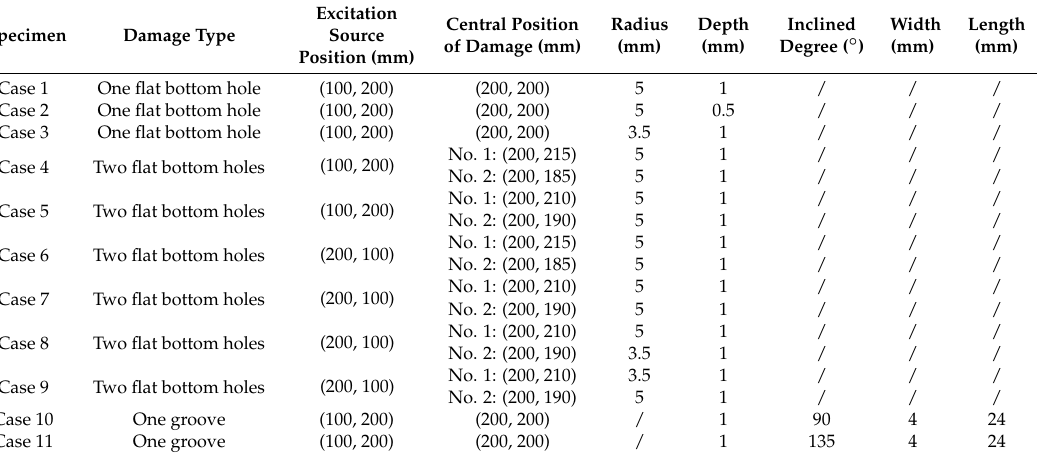
Figure 5. The excitation signal in the ( a ) time-domain; ( b ) frequency-domain. Table 2. Specimen parameters.